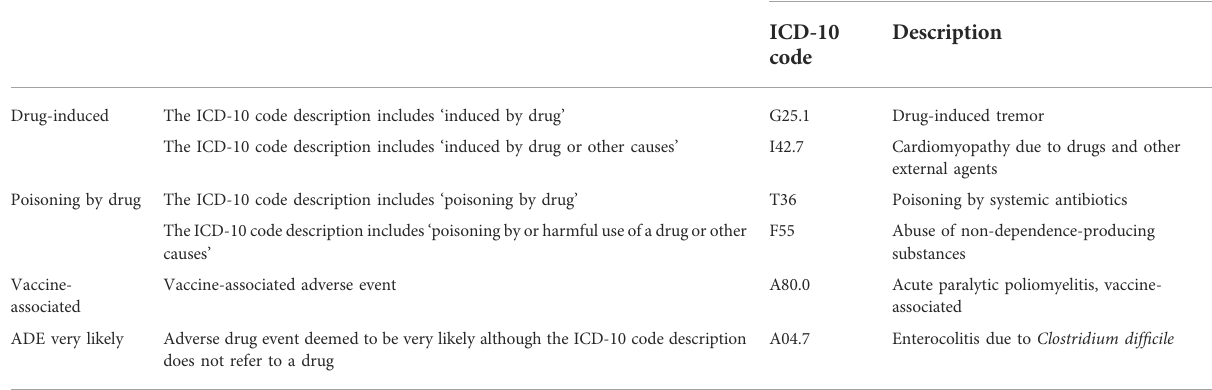
TABLE 1 De fi nitions of diagnosis codes and examples of adverse drug